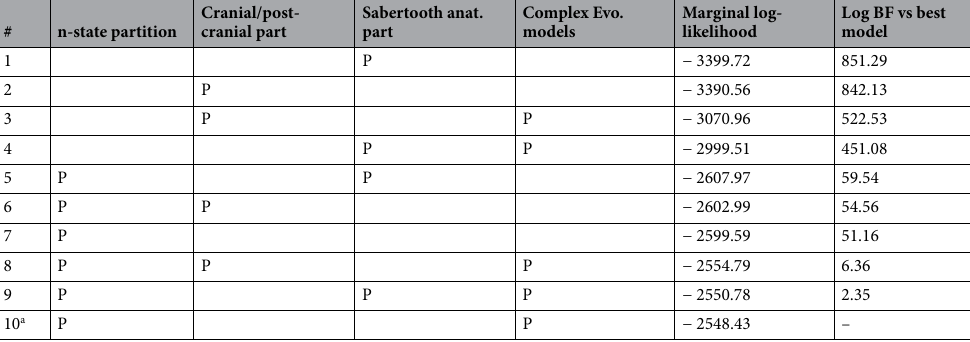
Table 1. Summary of marginal log-likelihoods and Bayes factor (BF) support for differential substitution models and partitioning schemes of the morphology data. Log BF values are reported as the support of the best model (model 10) over the inline model. P partition used. a Best supported